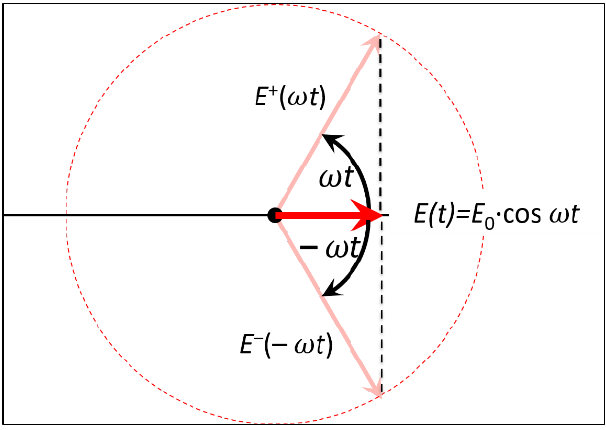
Figure A1. Phasor representation of an oscillation q  cos ωt .